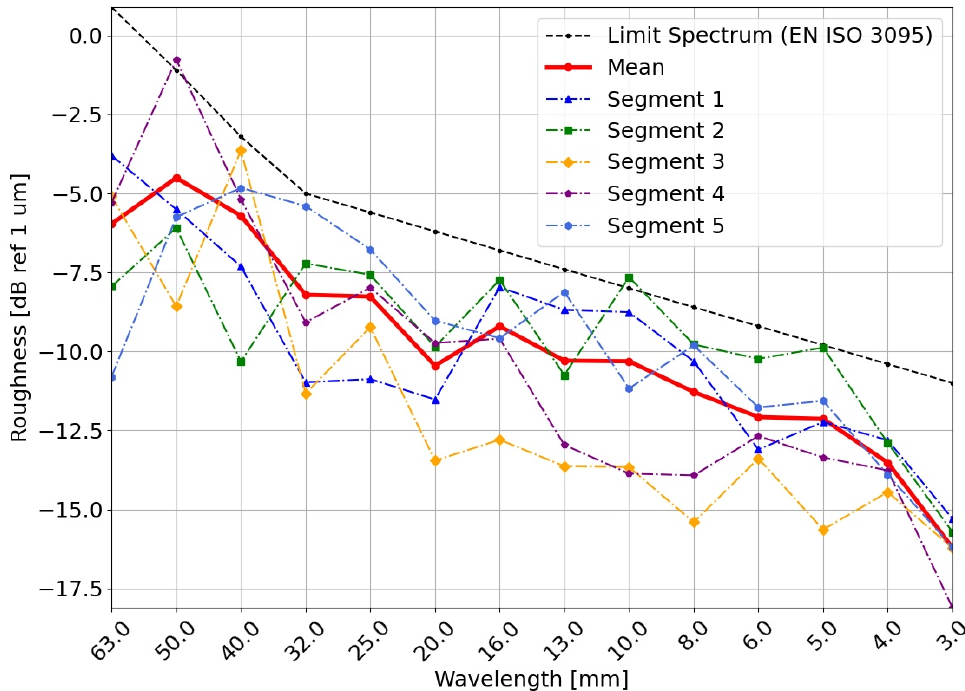
Figure A6. Spectrum of acoustic roughness for five adjacent measurements and the evaluated mean of the optical system at 50 km h − 1 and the limit spectrum from EN ISO 3095